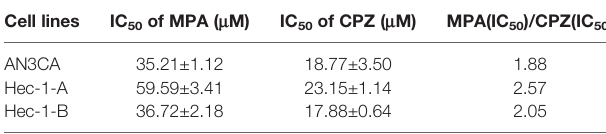
TABLE 2 | The 72-hour abilities of MPA and CPZ to inhibit proliferation in other EC cell lines. Cell